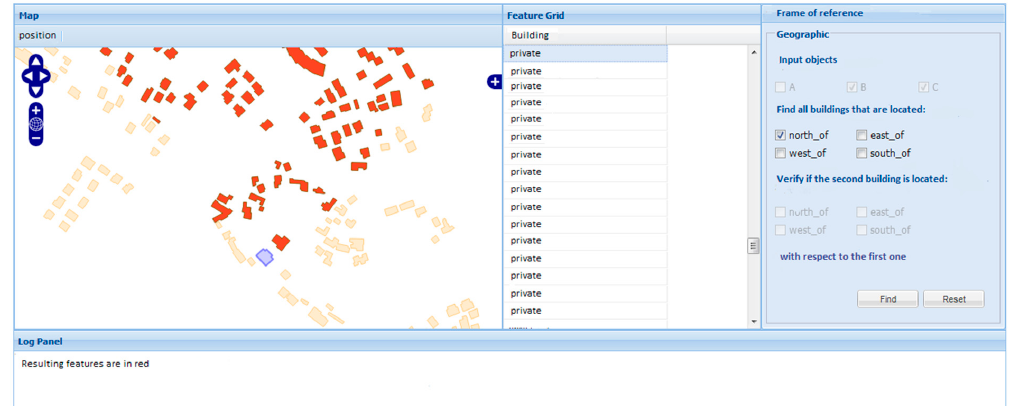
Figure 13. Buildings north of the selected one.